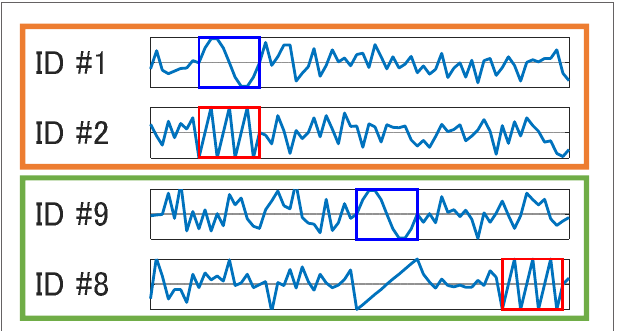
FIGURE 2 | An illustration of one type of difficulty in equivalence structure extraction. There is a pattern for ID #1 that is similar to a pattern for ID #9, as